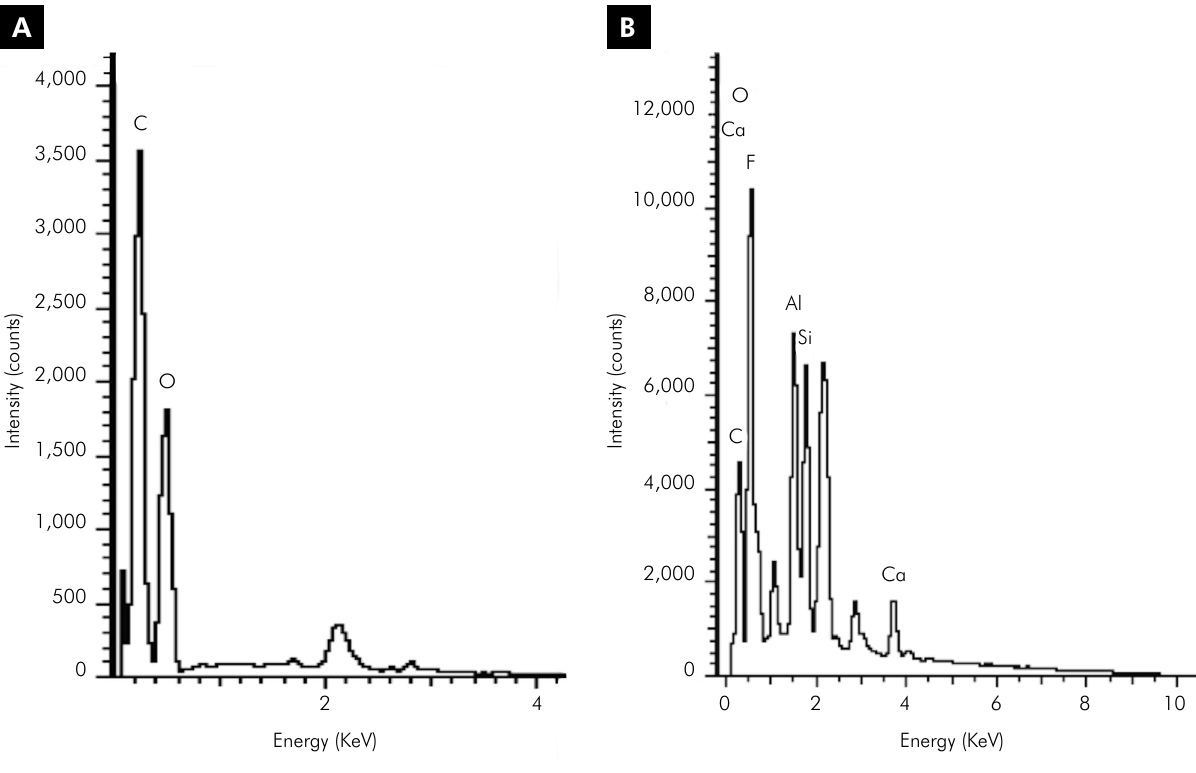
Figure 2. (A) EDS spectra of cellulose fibers ( × 2,500) and (B) fracture area of GICMF2 composite ( × 100); 10 and 15 kV;